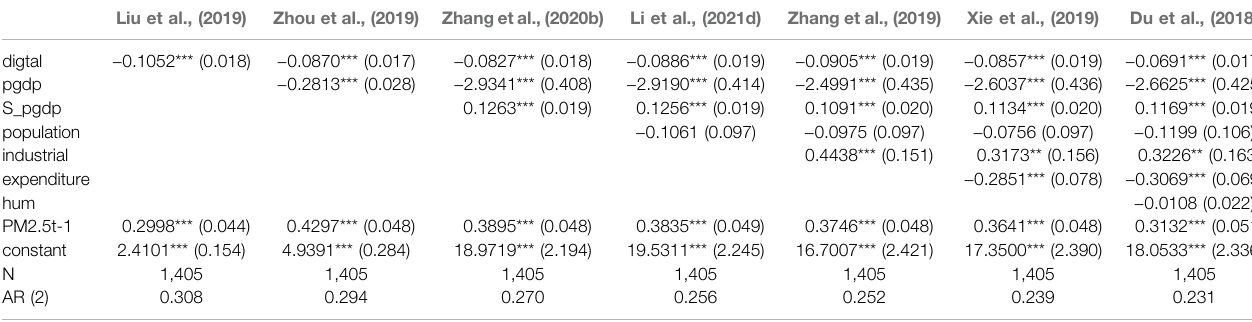
*Indicates signi fi cance at the 10% level. **Indicates signi fi cance at the 5% level. ***Indicates signi fi cance at the 1% level; standard error of robustness is reported in parentheses.